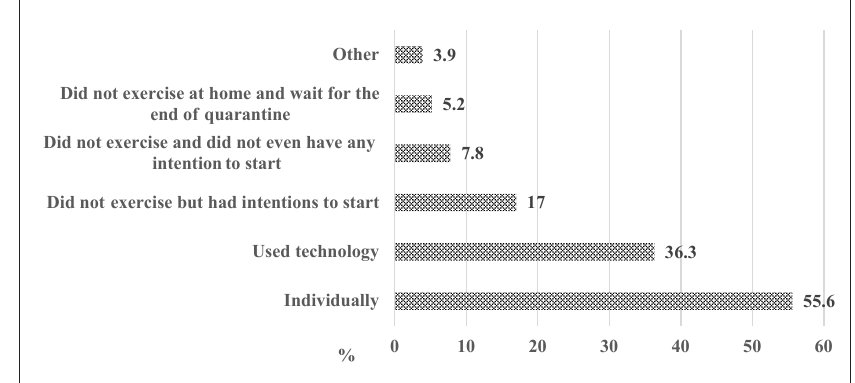
Figure 3. Distribution of respondents according to the average physical activity intensity indicators in the group of high FA level Figure 4. Nature of respondents’